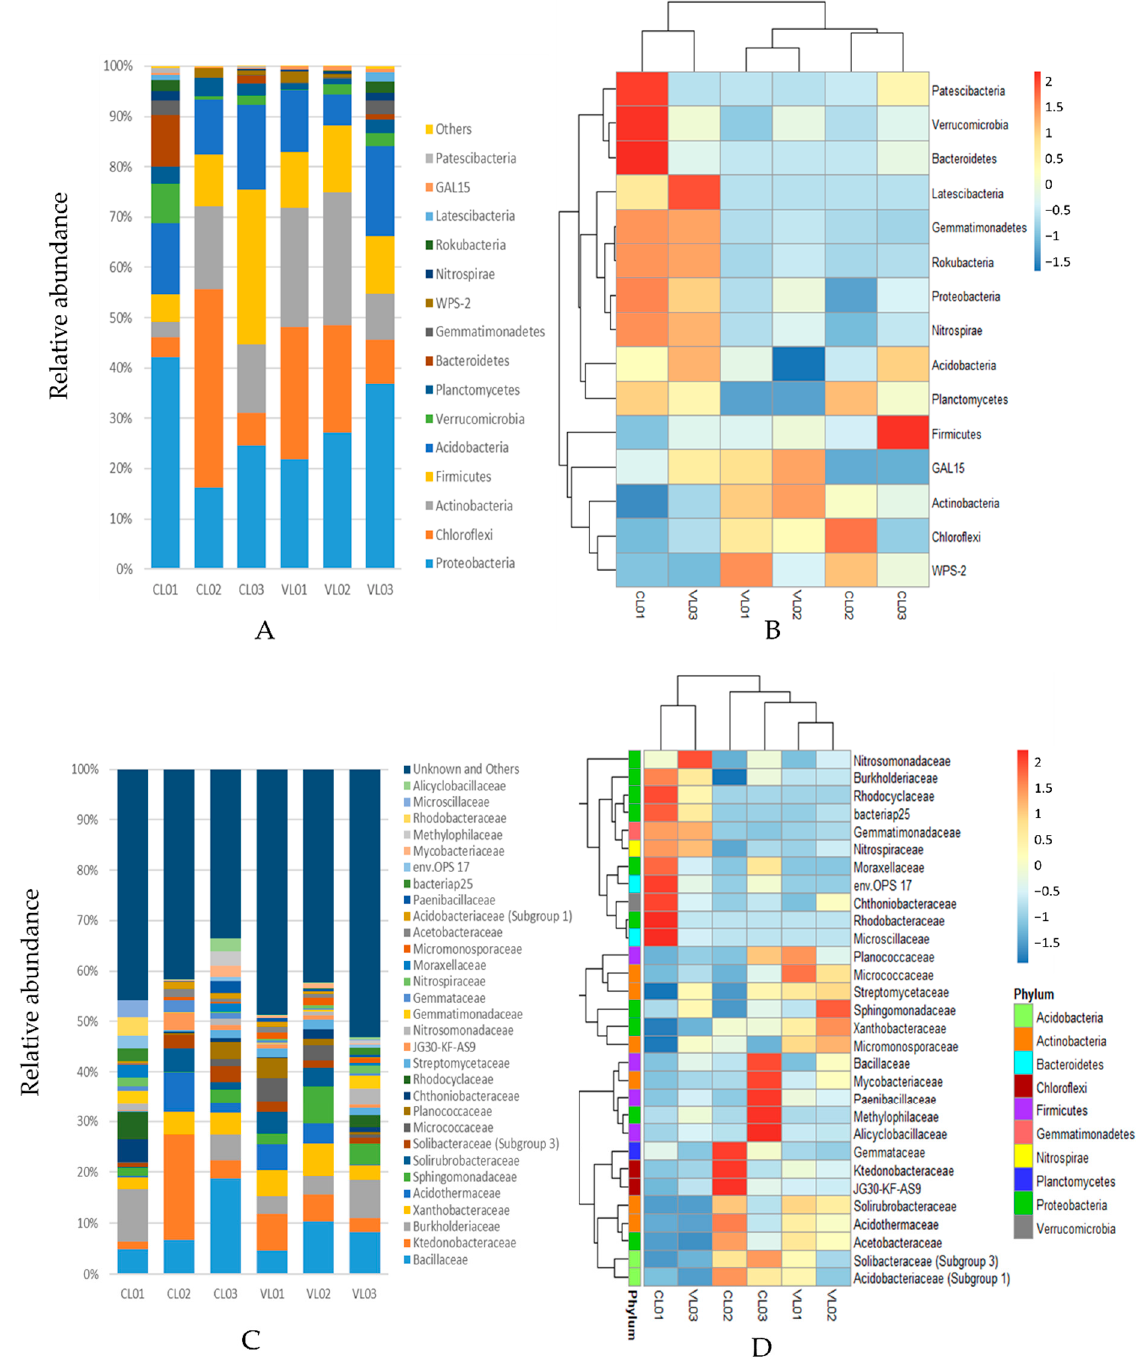
Figure 1. Relative abundance of 16S rRNA gene sequences classified to phylum level: top 15 phyla ( A ), family level: top 30 families ( C ). Heatmap illustrating relative abundance of the 15 most abundant bacterial phyla ( B ) and top 30 families ( D ) in the six soil samples. Relative abundance is indicated by a colour gradient from blue to red with blue representing low abundance and red representing high abundance.